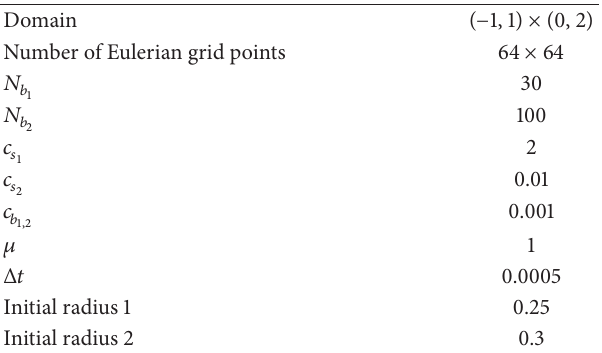
Table 2: Values of the constants associated with the filament and circular boundary.